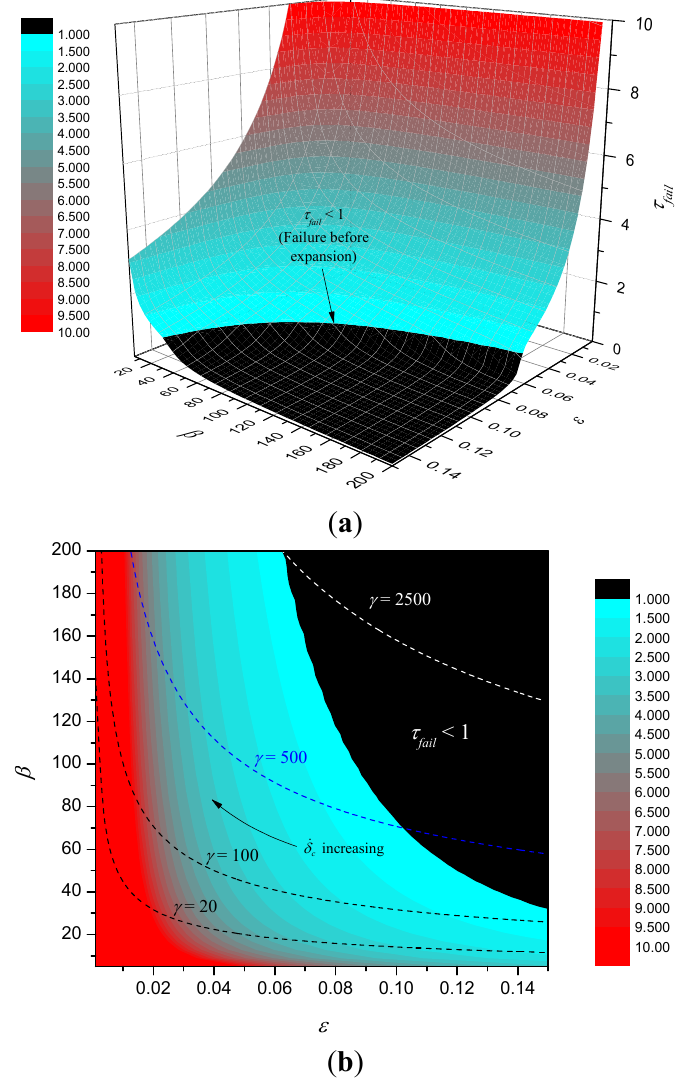
Figure 10. Surface map of τ fail ( a ) and contour plot ( b ) .